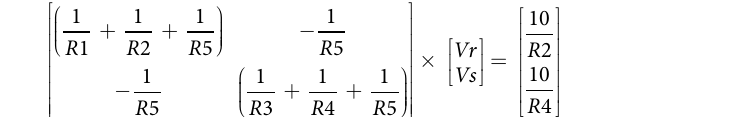
center of the hexagon, and cathodes representing the draining venules were connected at every other corner of the hexagon. The voltage was set as 51 V at the anode and 23 V at the cathodes to correspond with the intravascular